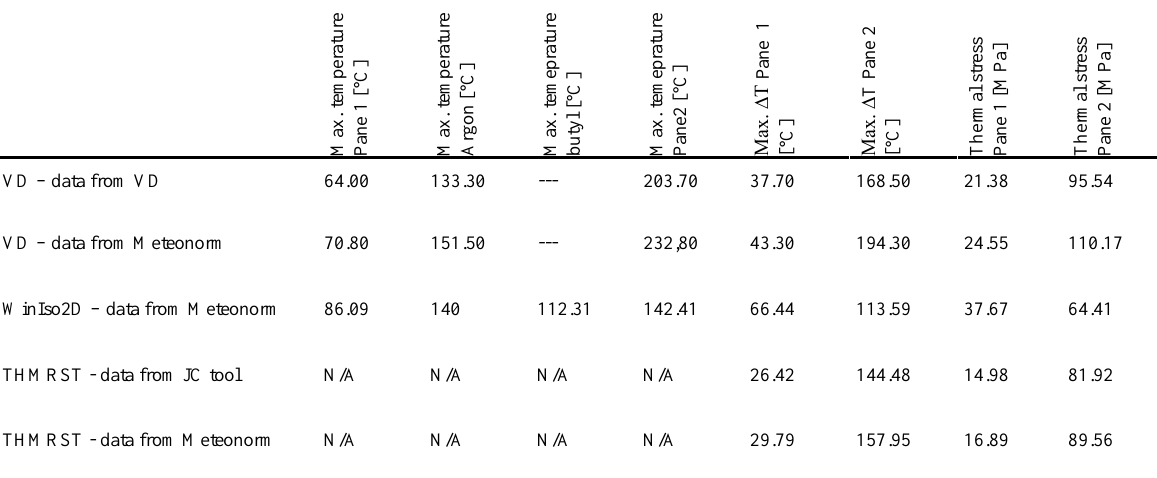
Table 8: Difference between a 1D and 2D analysis – SPANDREL + black frit